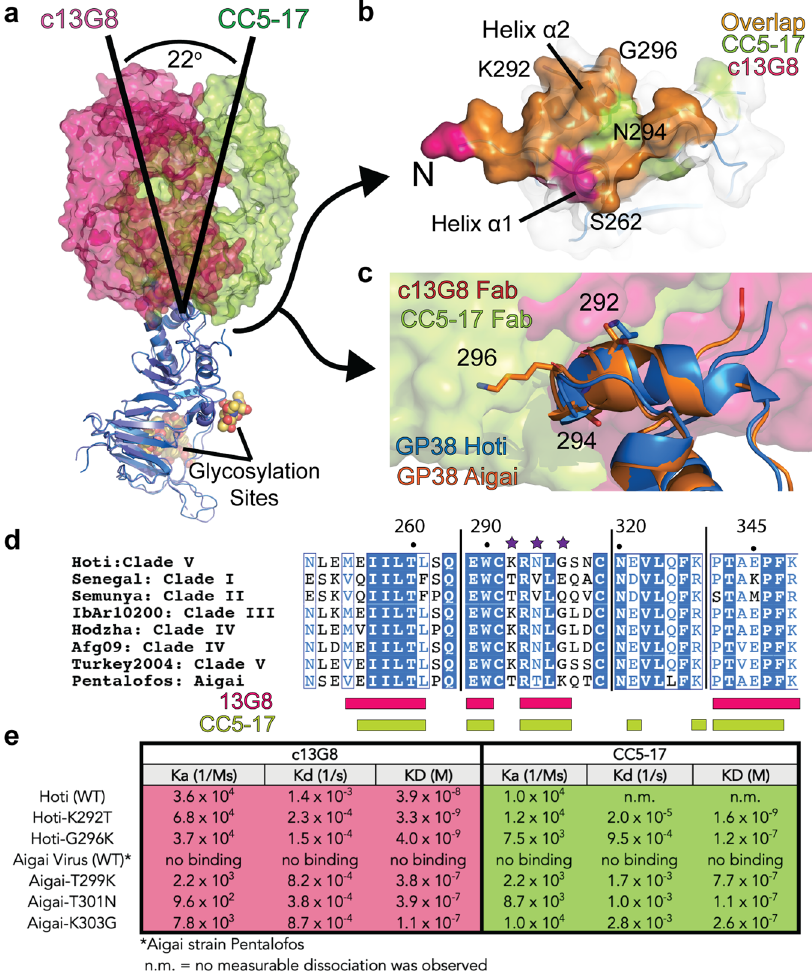
Fig. 3 | GP38 site I investigation. a Comparison of c13G8 (magenta) vs. CC5-17 (lime) engagement with GP38 site I epitope. b Surface area comparison of site I epitope,magentashowingsurfaceareaof13G8engagement,limedenotingsurface area of CC5-17 engagement, and orange denoting the shared surface area of the twoFabs. c HomologymodelofGP38fromAigaivirus(orange)overlayoncomplex